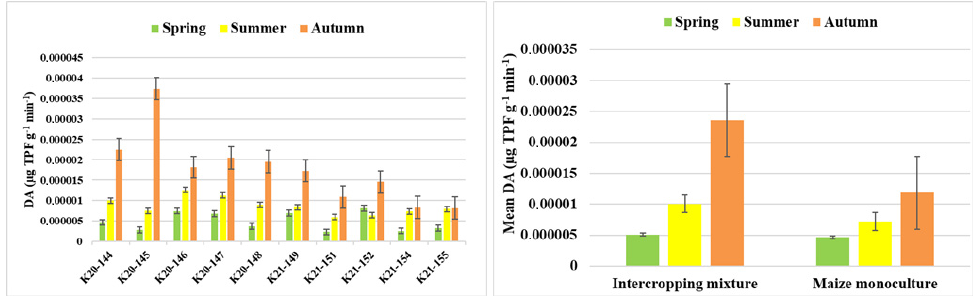
Figure 3. Dehydrogenase activity (DA) in the rasters of field K20 under the intercropping mixture and field K21 under the maize monoculture in spring, summer, and autumn.